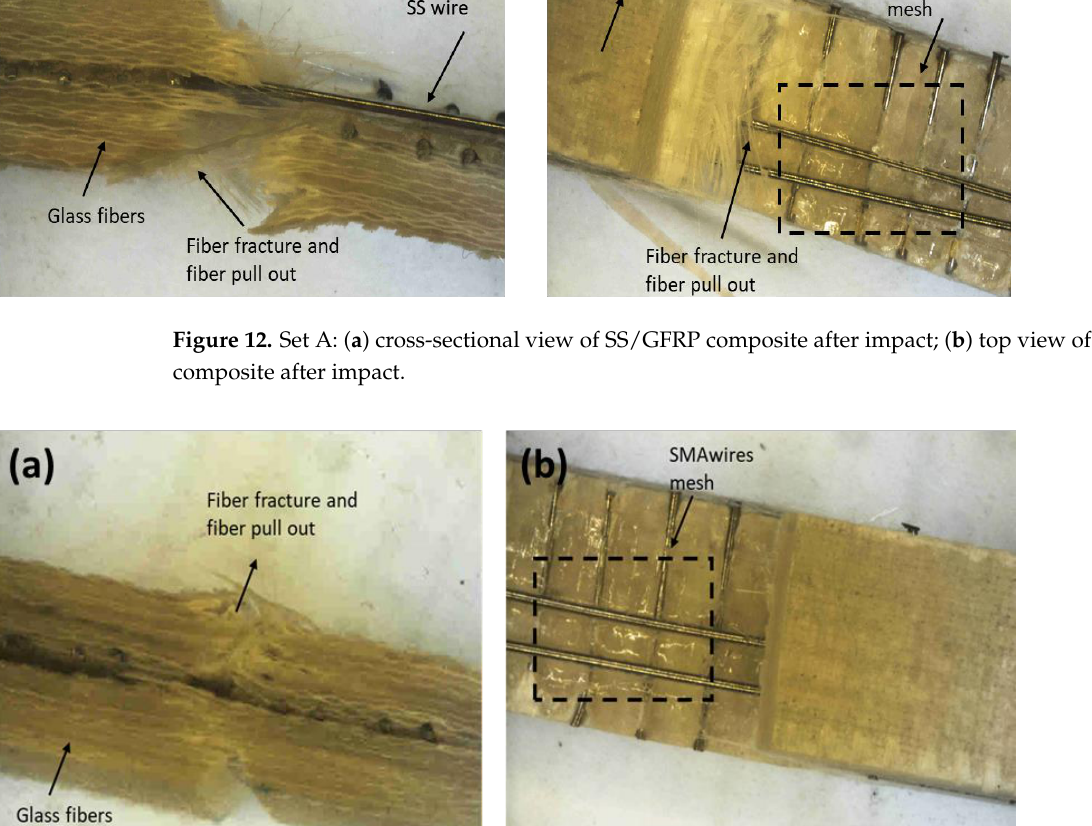
Figure 13. Set A: ( a ) cross-sectional micrograph of SMA/GFRP composite after impact; ( b ) top view of SMA/GFRP composite after impact.